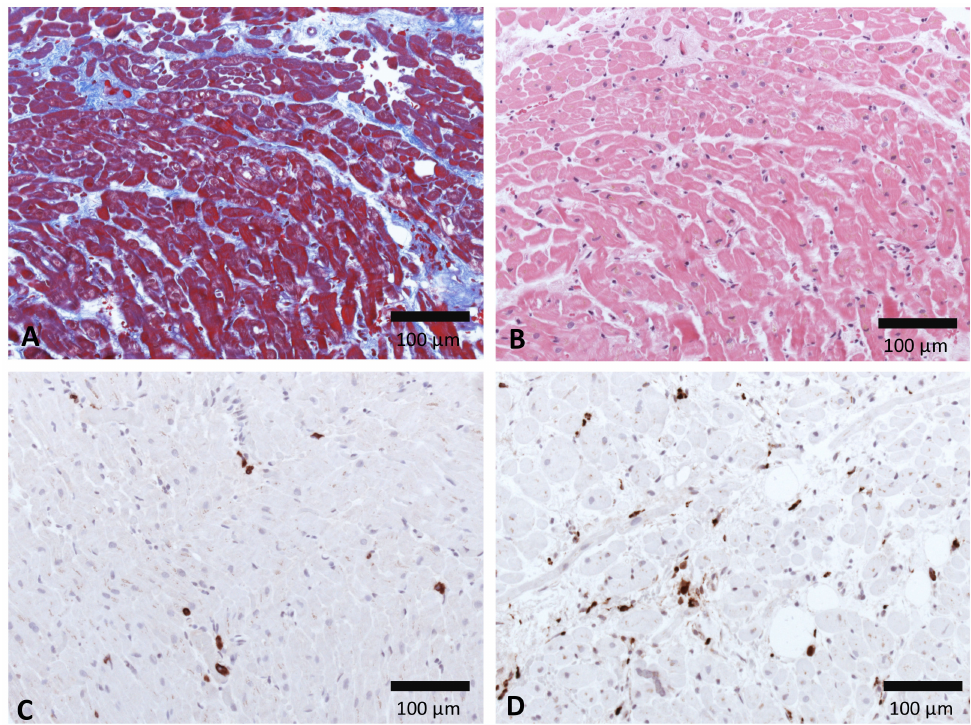
Figure 5. Healing myocarditis in a SARS-CoV-2 positive patient (75 years old, male). ( A ) Masson Trichrome ( B ) H&E, ( C ) CD3+ T cells, ( D ) CD68+ macrophages of the interstitium (bar = 100 µ